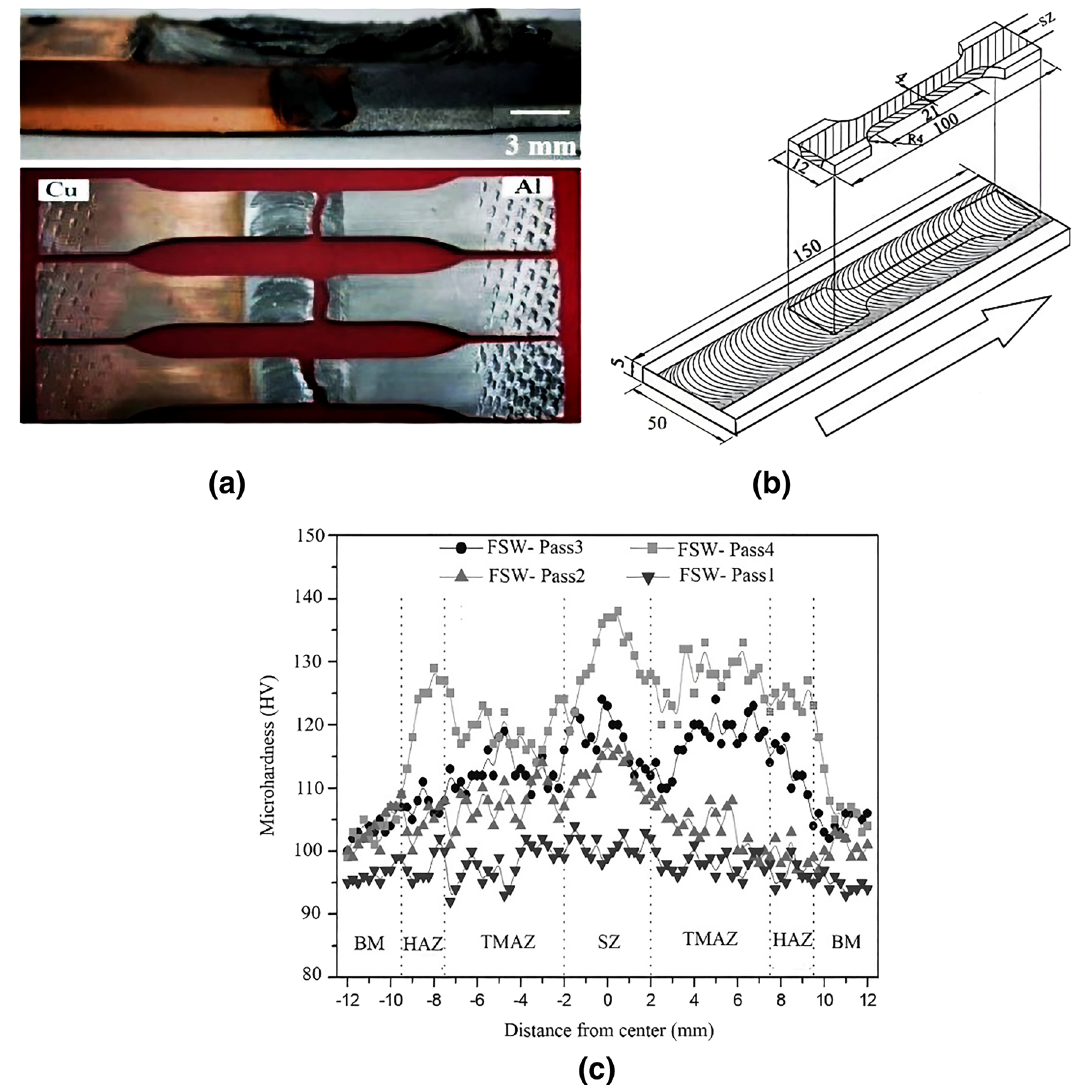
Fig. 2 image of the; a tensile test specimens, b tensile test dimensions and c